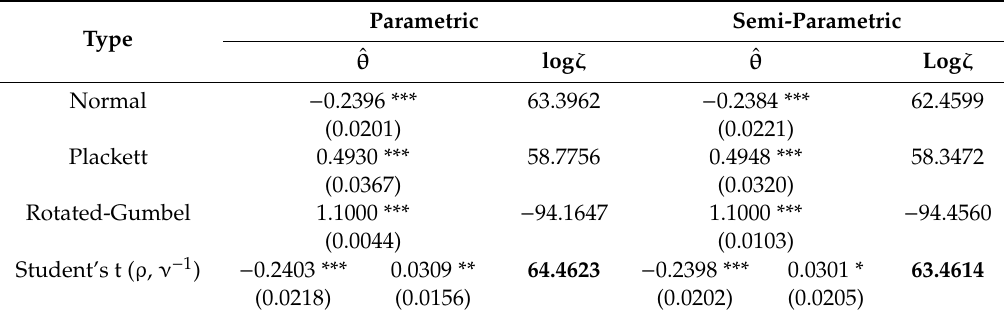
Table 6. Constant copula parameter estimation (Brazilian Real—BRL).